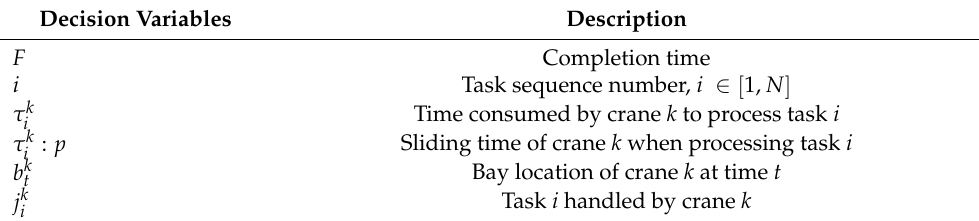
Table 2. Descriptions of decision